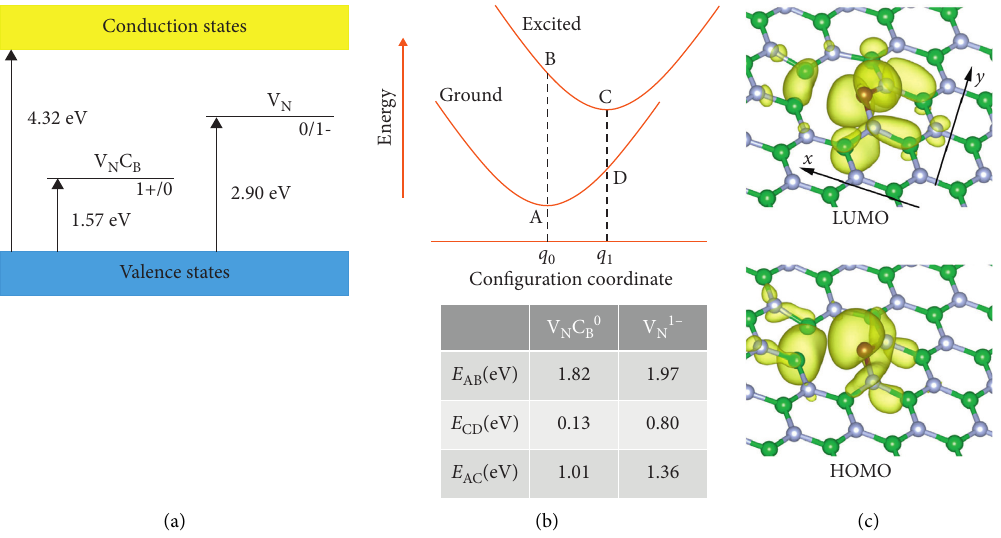
Figure 3: (a) Charge transition level (CTL) of defects. For V C N B , CTL between 1+ and neutral state is shown while it is between neutral and 1 − charge state for V N , where our calculated band gap is 4.32eV. (b) Schematic representation of types of the optical transition. The x -axis is for the configuration coordinate which indicates distances among atomic configurations, where q is for the lowest energy atomic 0 for that of an electronically excited state. In the table, optical absorption ( E AB ) , configuration of the electronic ground state while q 1 emission ( E C D ) , and ZPL ( E AC ) energies are shown for the two defect structures. (c) Isosurface representation of the squared amplitude of symmetry is chosen as x -direction and its perpendicular direction in the wave functions (| ψ | 2 ) of HOMO and LUMO. The mirror axis of C 1 h plane of a single atomic layer is along y